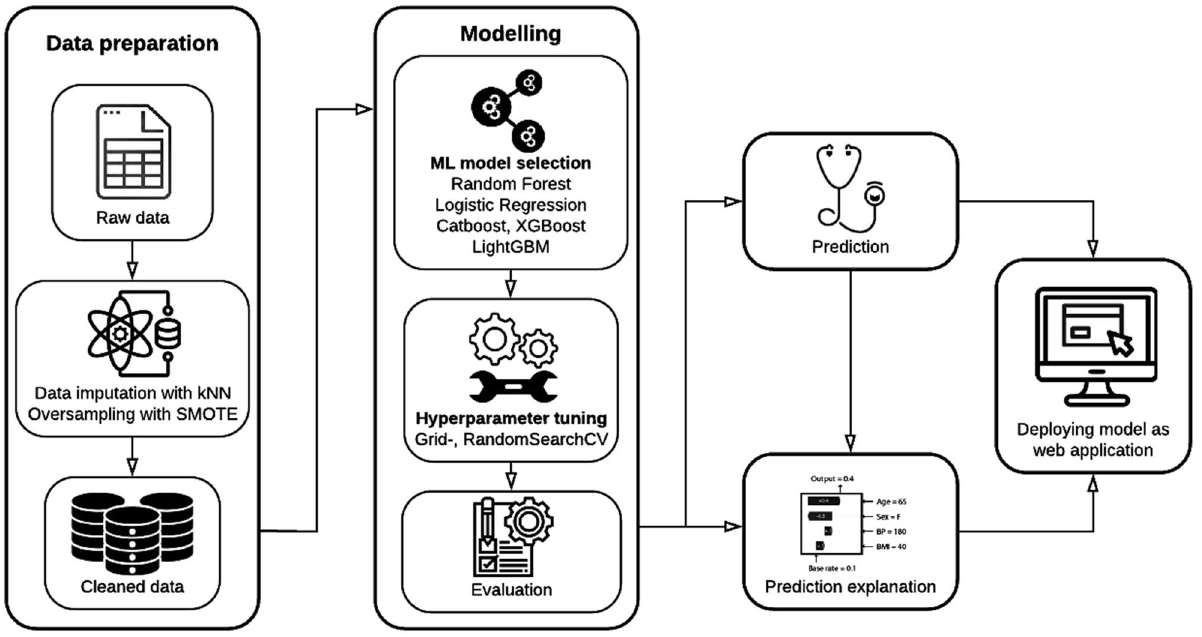
Figure 1. Flowchart representing the process of developing the